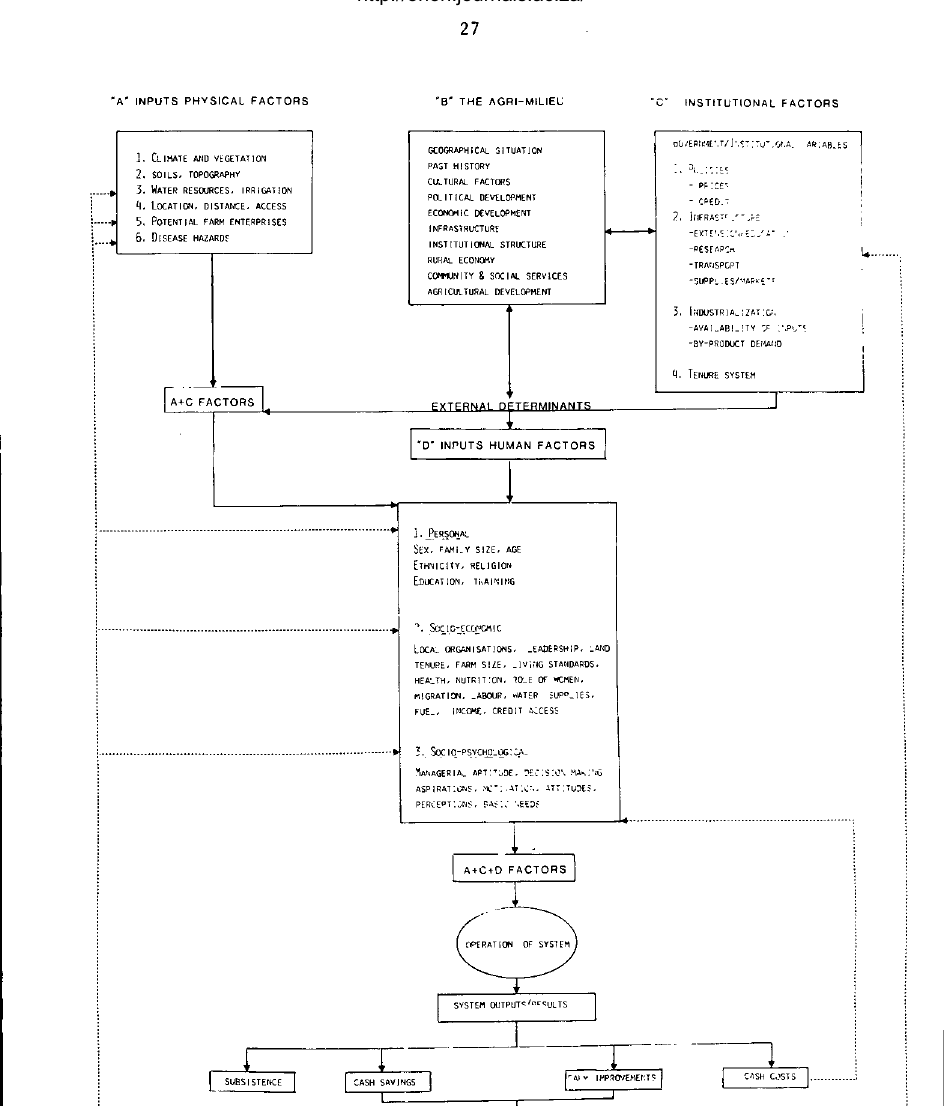
Fig. 1 Determinants of a Farming